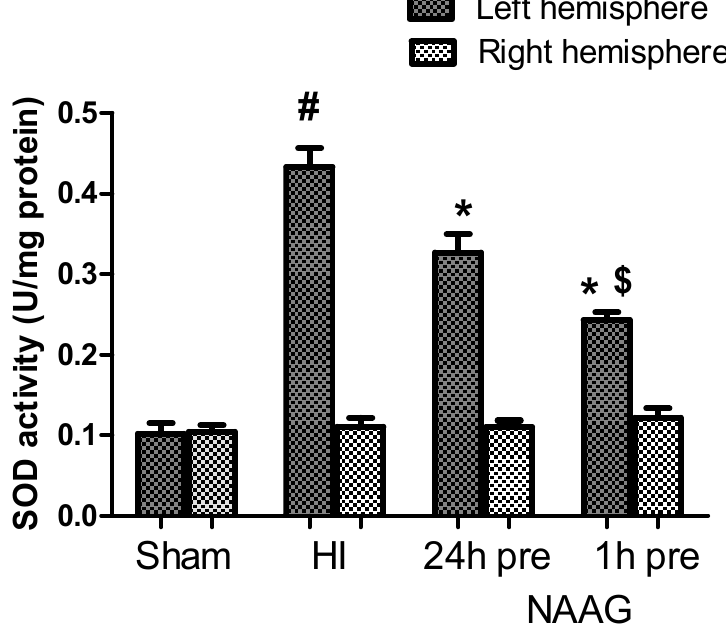
Figure 4. E ff ect of NAAG application on HI-induced changes in SOD activity. The results are presented as the means ± SEM, n = 6; statistically significant di ff erences: * p < 0.01, compared to the HI group; Figure 4. Effect of NAAG application on HI ‐ induced changes in SOD activity. The results are # p < 0.001 compared to the sham operated group; $ p < 0.01 compared to the NAAG 24 h pre presented as the means ±SEM, n = 6; statistically significant differences: * p < 0.01, compared to the HI